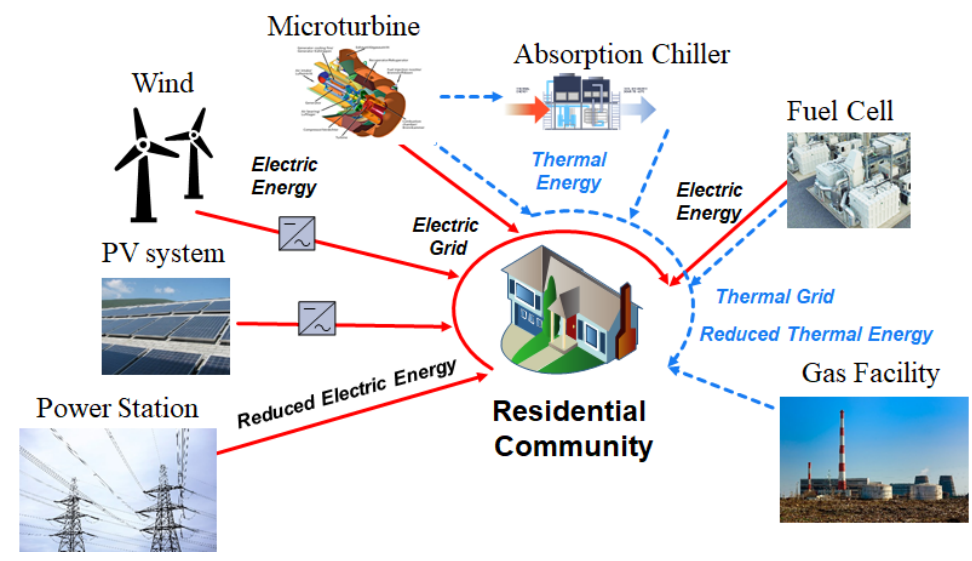
Figure 1. Considered residential community energy hub with electric power grid, thermal utility, PV, wind turbine, MT, AbC, and FC systems .